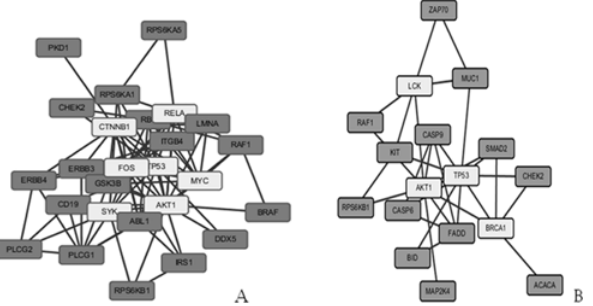
Fig 5. Key nodes of the PPI network visualized by Cytoscape software. All nodes that have a centrality value greater or equal to the threshold are highlighted with a light gray color in the network view. (A) up- regulated proteins; (B) down-regulated proteins.